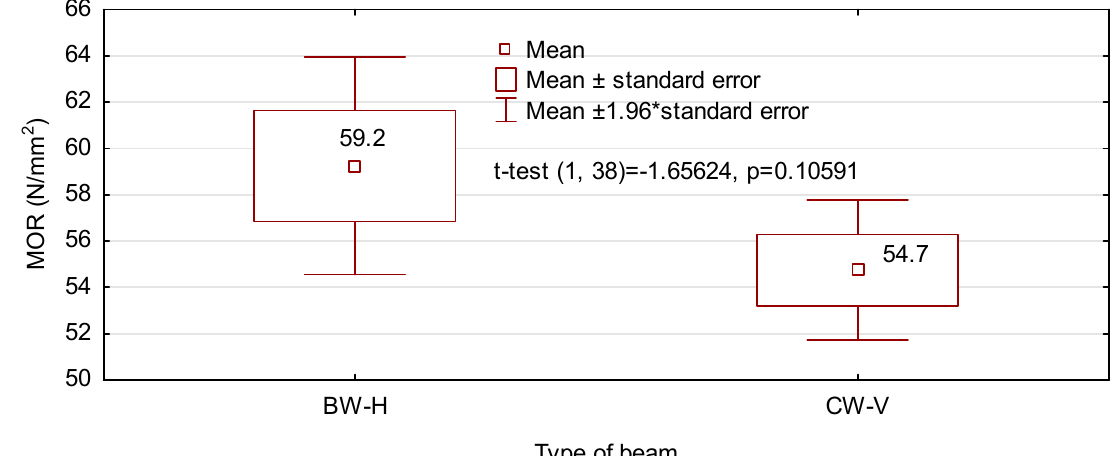
Figure 9. Static bending strength.